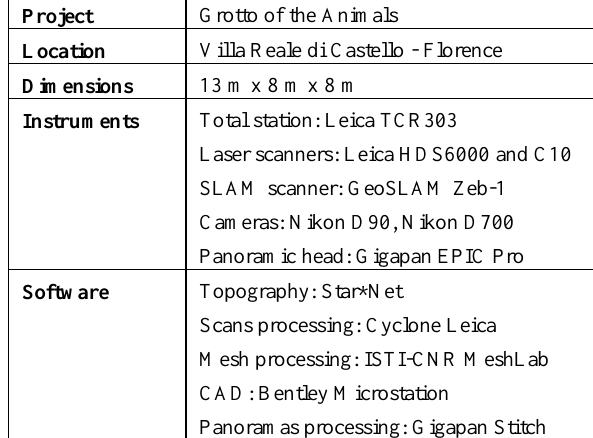
Table 1. Summary of project data and